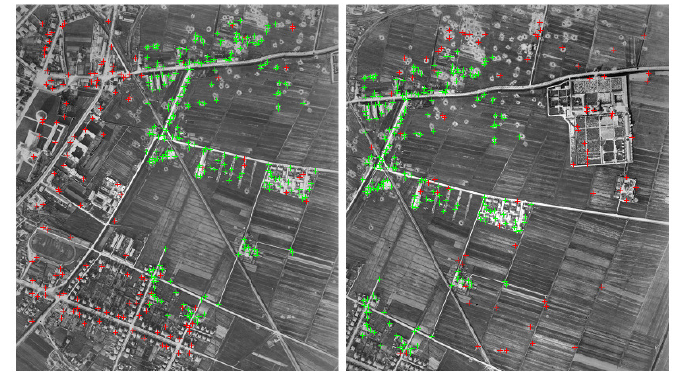
Figure 1. Two photos with feature points shown as crosses. The green ones are found to be corresponding points (matching points) by the algorithm. The red ones are false matches and are not used for stitching ( c (cid:13) MiBAC-ICCD, Aerofototeca Nazionale, fondo RAF).